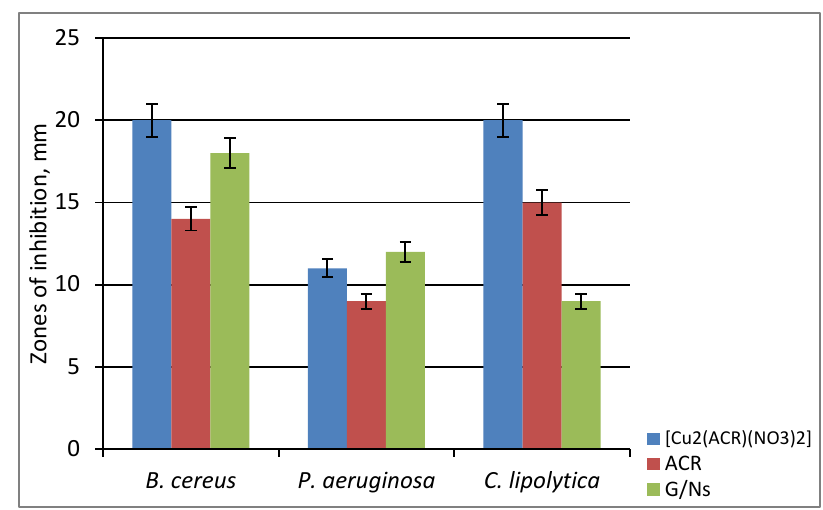
Figure 4. Zones of inhibition of the model strains by 0.06 g of the investigated ACR and [Cu 2 (ACR)(NO 3 ) 2 ]. G, Gentamicin; Ns, Nystatin.